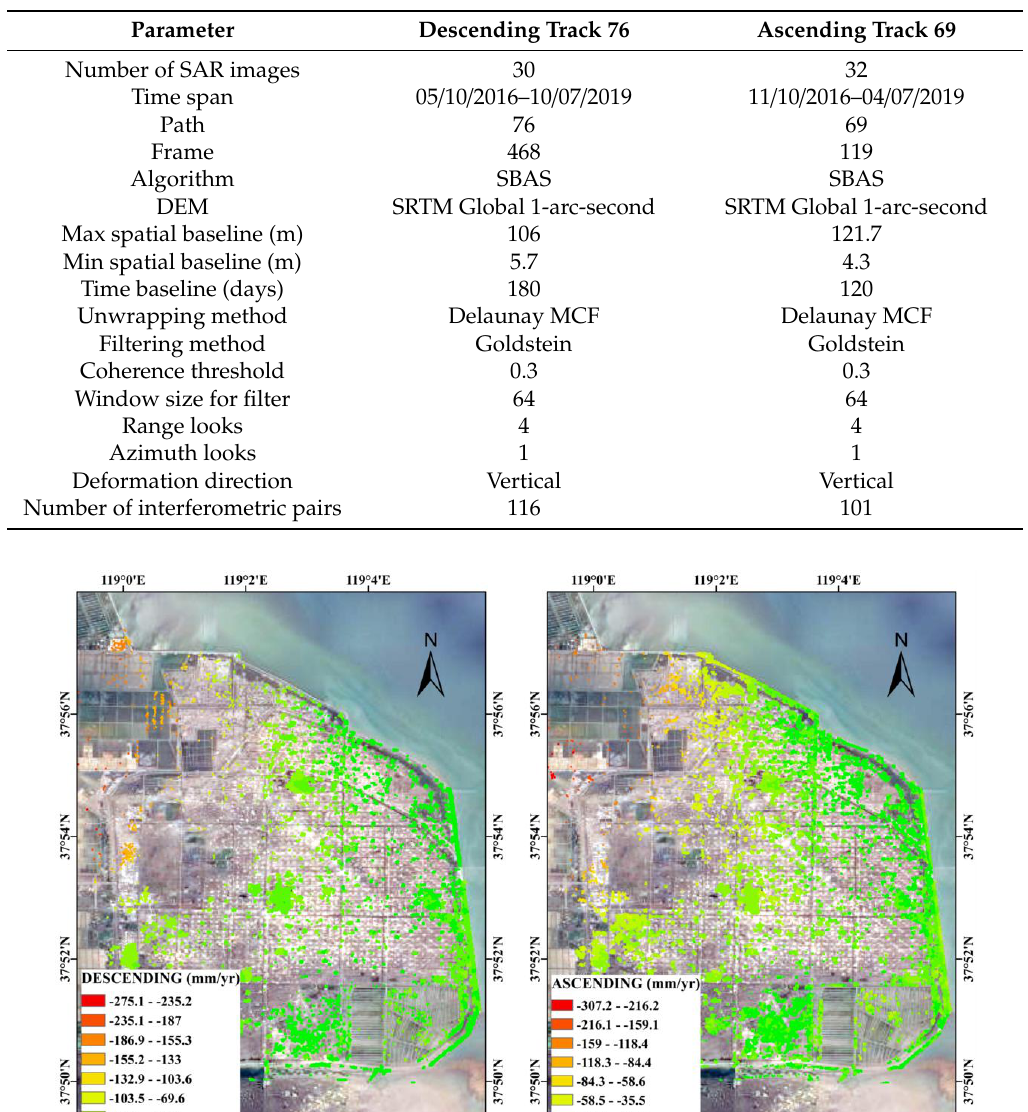
Table 2. SBAS InSAR parameter setting.